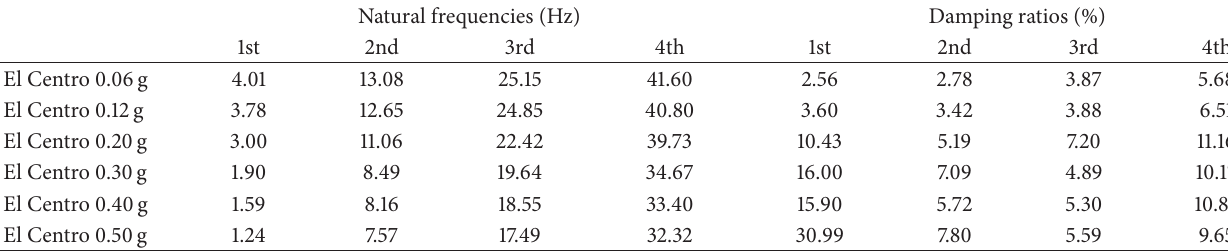
Table 1: Natural frequencies and damping ratios of the test